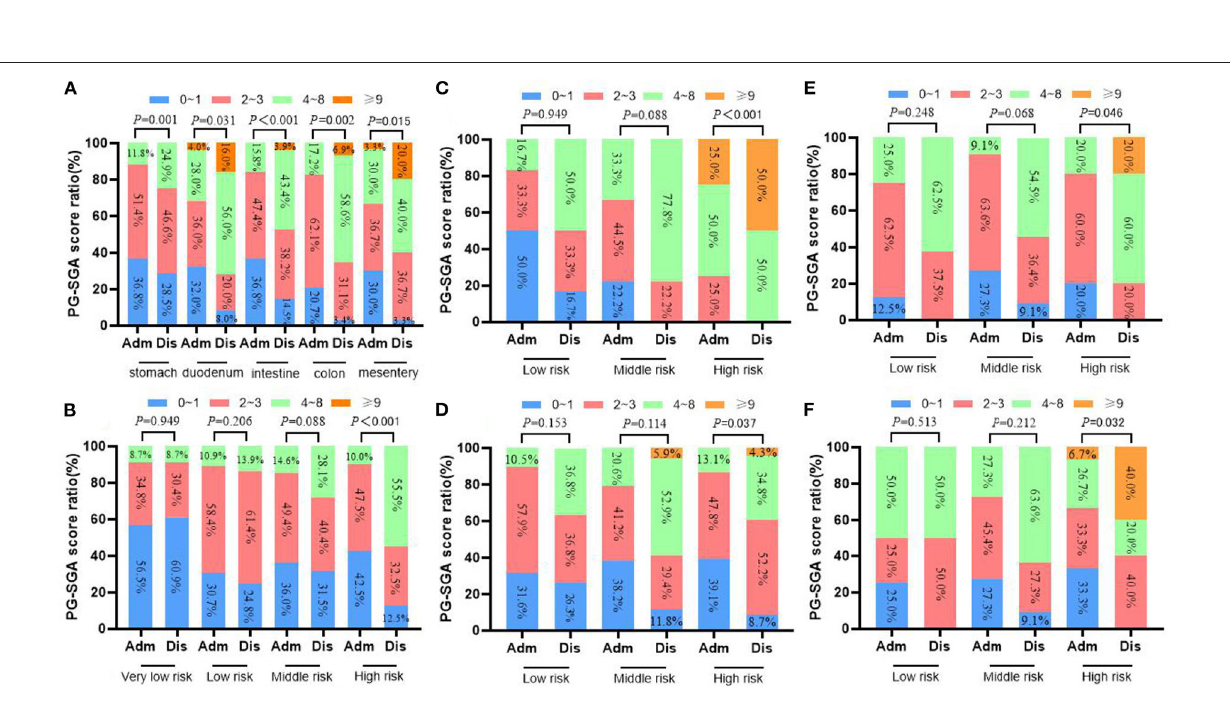
Frontiers in Nutrition | www.frontiersin.org